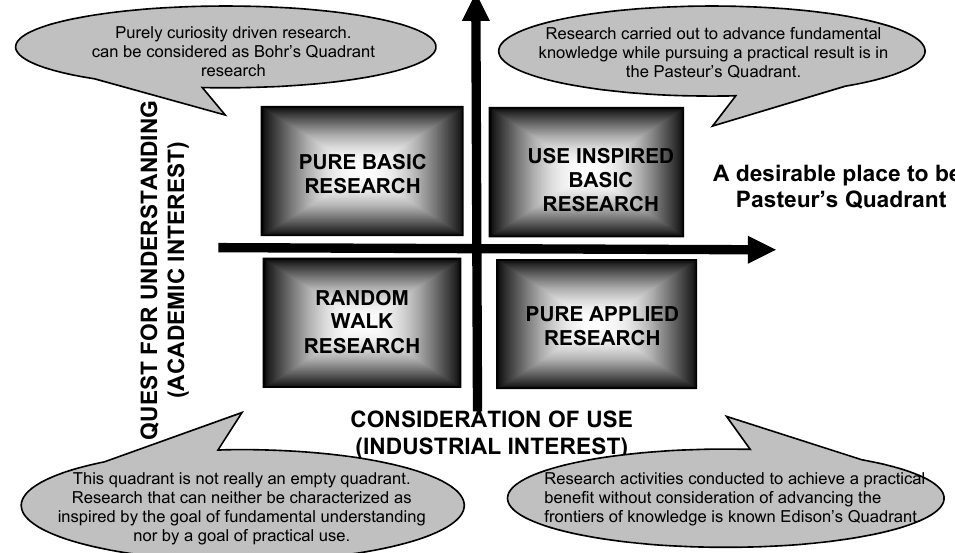
Figure 19. Importance of Pasteur’s Quadrant.